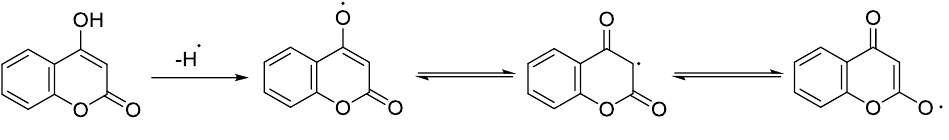
Figure 16. Resonance stability of phenoxy radical of 4-hydroxy coumarin (C 2